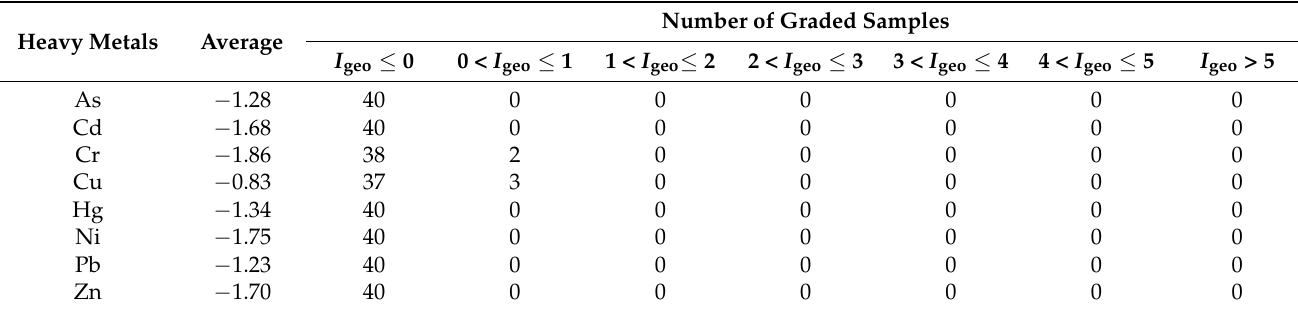
Table 6. I geo classification statistics for heavy metals in surface soil of non-karst